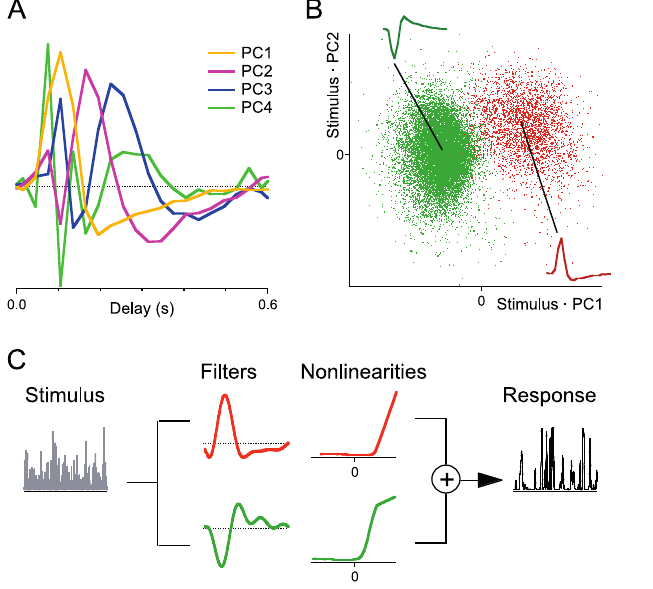
Figure 4. A 2LN Model for Ganglion Cell Responses (A) Principal component analysis (PCA) of the spike-triggered stimulus. For each spike from the neuron of Figure 2C, we identified the stimulus waveform in the preceding 1 s. This set of spike-triggered stimuli was subjected to PCA. The graph shows the first four principal components (PC1–PC4), plotted as a function of time before the spike. (B) The set of spike-triggered stimuli projected onto the first two principal components. Each point derives from one of the cell’s spikes. Two clusters are apparent, and the waveforms corresponding to the cluster centers are plotted above or below the respective cluster. (C) Diagram of the 2LN model for this ganglion cell. The stimulus intensity waveform passes through two parallel LN pathways with On and Off filters, respectively. After a rectifying nonlinearity, the outputs of the two pathways are summed to predict the firing rate of the ganglion cell. (top-left quadrant in Figure 6A) were moderately Off dominated at baseline and switched to moderately On dominated after the image shift. These correspond closely to the cells identified as undergoing polarity reversal by simple visual inspection of the linear filter (Figure 2C). This analysis shows that polarity reversal is merely a special case of a more general phenomenon, namely a relative enhancement of the On pathway, which affects the majority of all retinal ganglion cells in our sample.